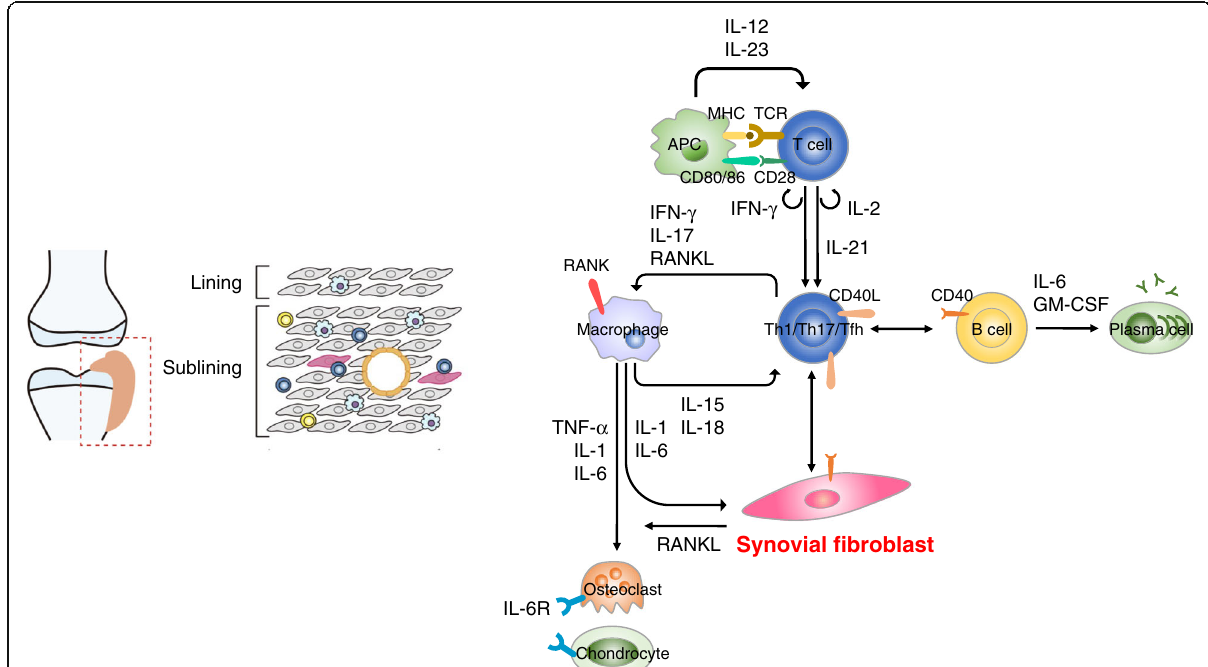
Fig. 2 The network of effector cells in the pathology of rheumatoid arthritis. APC, antigen-presenting cell; TCR, T cell receptor; MHC, major histocompatibility